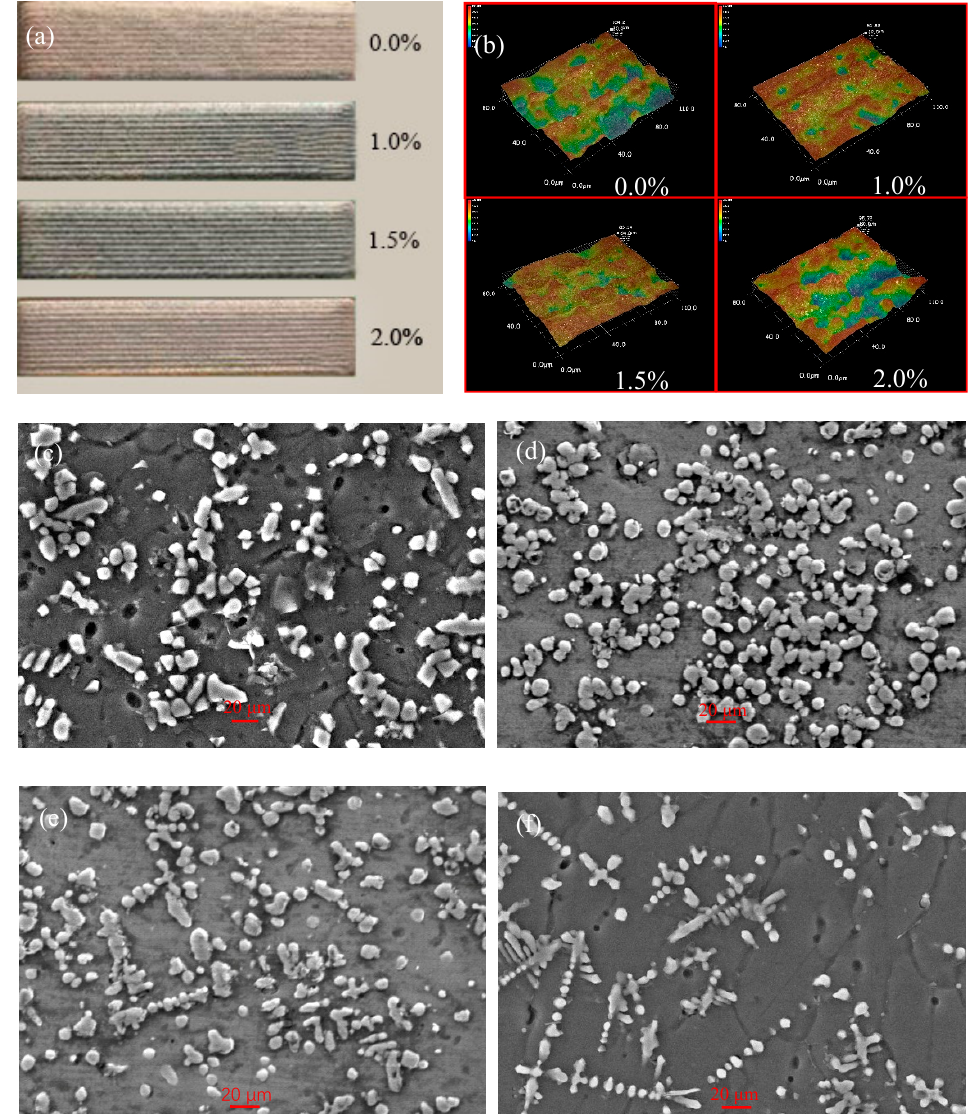
Figure 6. Macro-morphology ( a ), three-dimensional morphology ( b ), and micromorphology ( c , d , e , f ) of coatings with different CeO 2 content: ( c ) 0.0% CeO 2 , ( d ) 1.0% CeO 2 , ( e ) 1.5% CeO 2 , and ( f ) 2.0% CeO 2 .